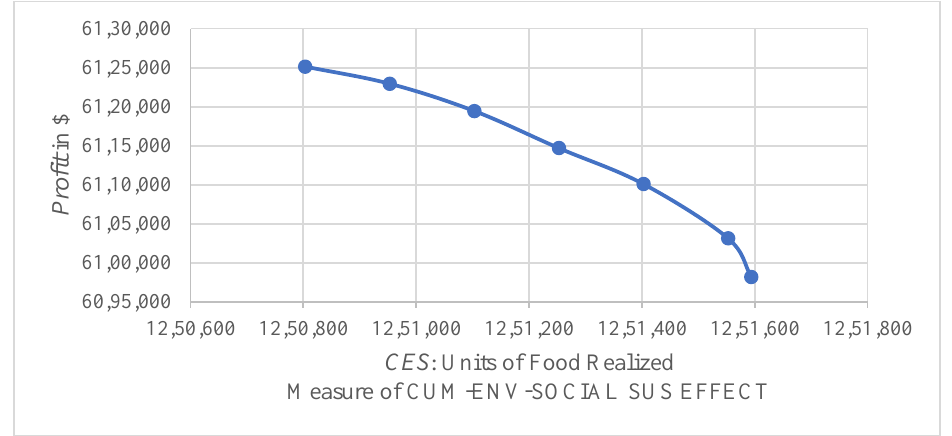
Figure 1. Pareto frontier Profit vs CES (equivalent CUM-ENV-SOCIAL